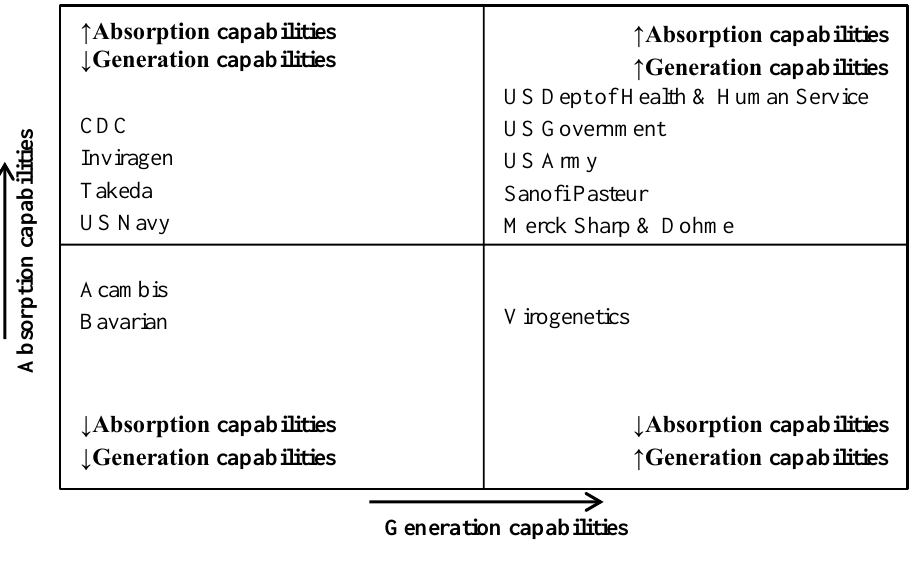
Figure 9. Holders’ classification by the number and type of